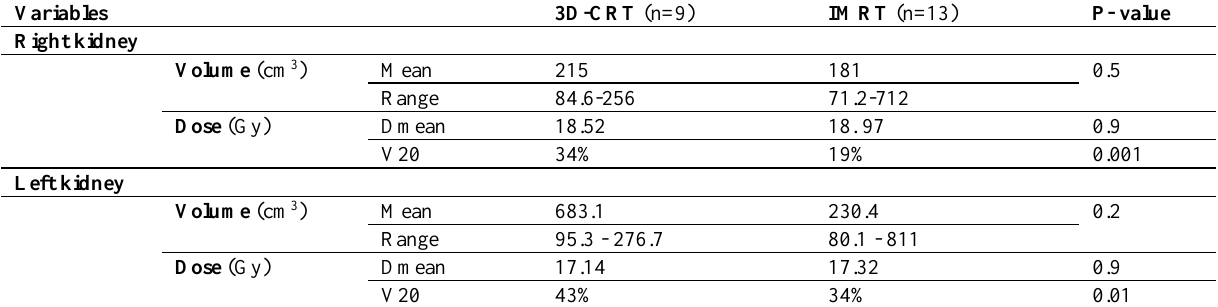
Table 2: Dose-volume histogram (DVH) parameters of both kidneys Variables 3D-CRT (n=9) IMRT (n=13) P- value Right kidney Volume (cm 3 ) Mean 215 181 0.5 Range 84.6-256 Dose (Gy) Dmean 18.52 V20 34% 19% 0.001 Left kidney Volume (cm 3 ) Mean 683.1